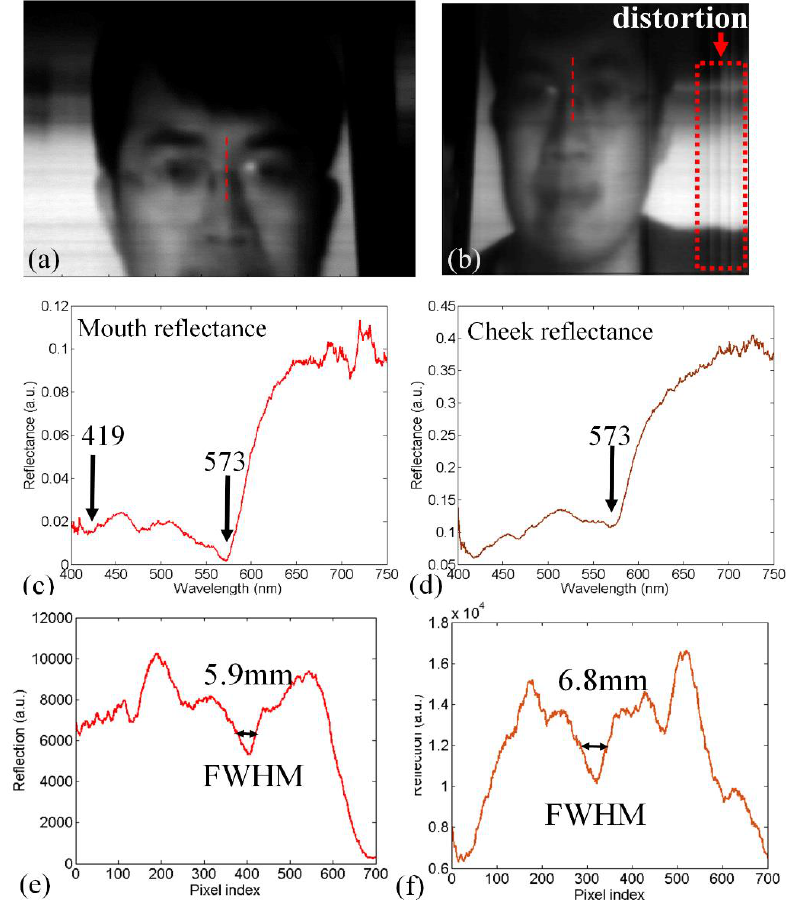
Figure 3. The selfie stick-based imaging spectrometer was utilized to scan the face of the second author. ( a ) The scanning results when the selfie stick was placed on a stable table; ( b ) the scanning results when the selfie stick was held by an assistant; ( c ) the reflectance spectrum from the mouth region; ( d ) the reflectance spectrum from the cheek region. ( e , f ) are the optical intensity profiles of the line regions indicated by the red dotted lines in ( a , b ), respectively.